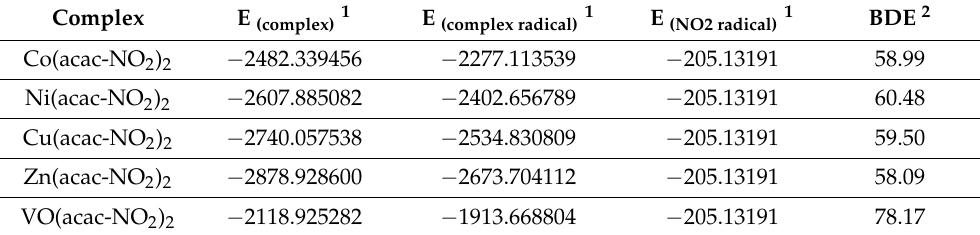
Table 1. Calculated bond dissociation energies (with zero-potential energy correction) of the weakest C-NO 2 bonds in studied nitro-bis(acetylacetonato)